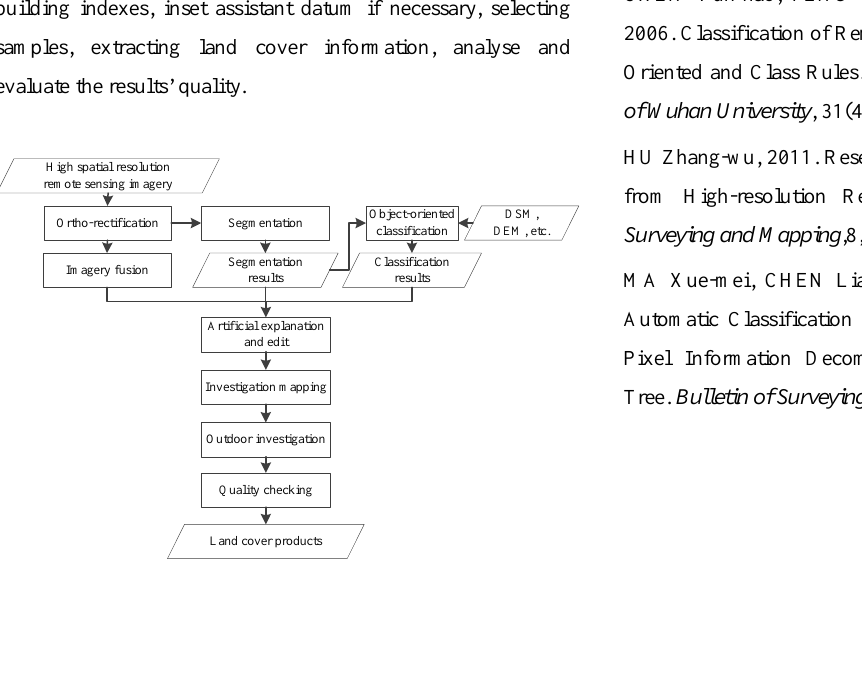
Figure 3. Flow charts of classification based on high spatial resolution remote sensing